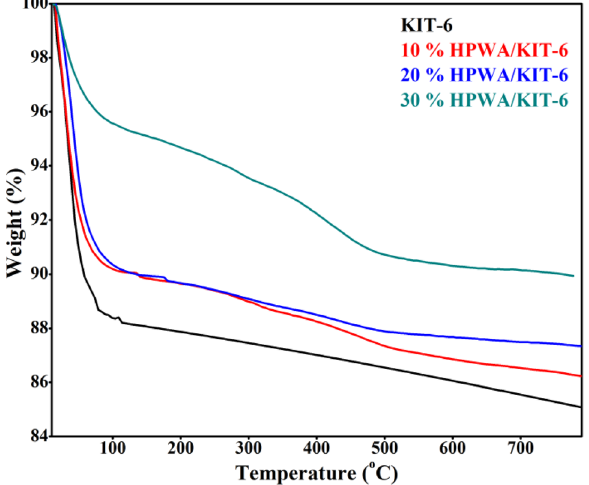
Fig. 8 Thermal gravimetric analysis of KIT-6, 10% HPWA/KIT-6, 20% HPWA/KIT-6 and 30%